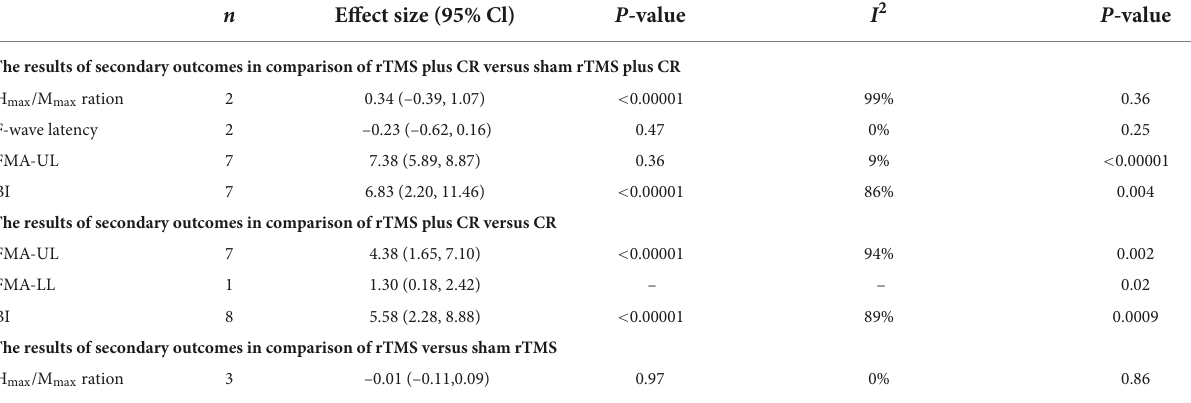
TABLE 3 The results of secondary